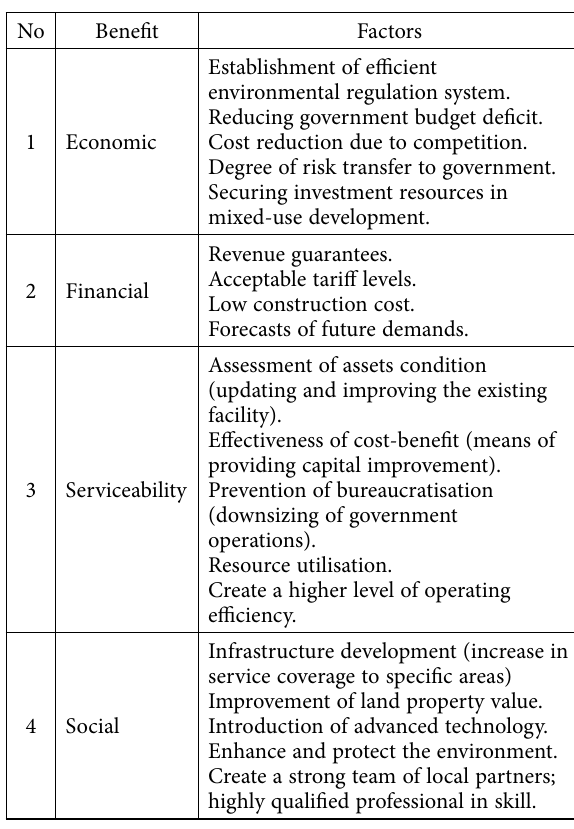
Table 4. Key performance indicators for the TBTR